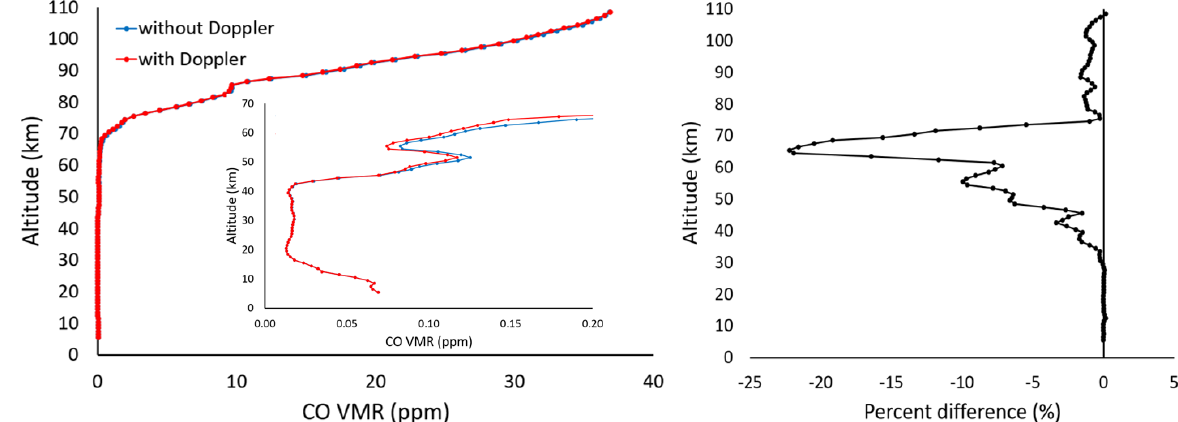
Figure 13. Left : Retrieved CO VMR profiles for occultation sr10063 with and without Doppler effect smearing included in the forward model. The inset magnifies the results below 70 km. Right : The percentage difference between the 2 profiles.